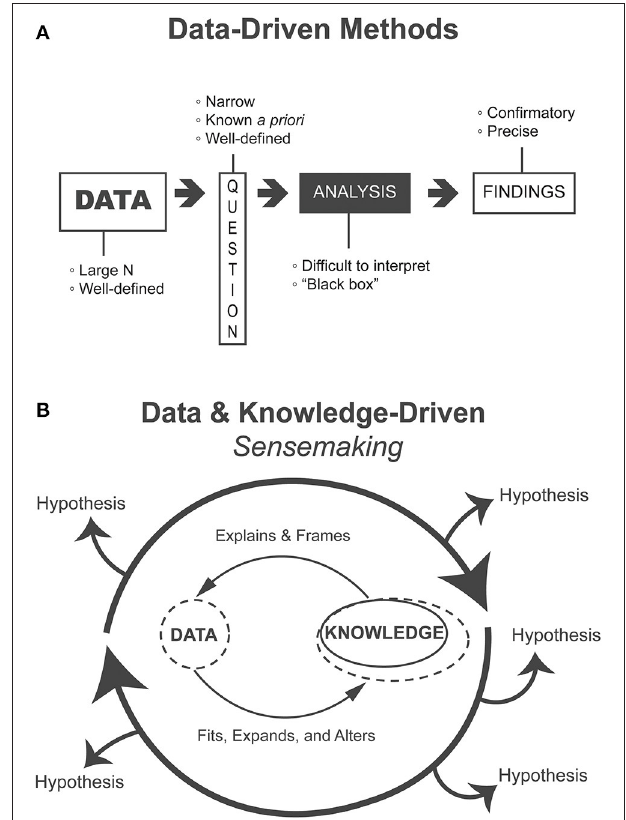
FIGURE 1 | (A) Heavily data-driven methods follow a linear flow from data to findings, require voluminous data to address narrow questions that are known ahead of the analysis, and produce confirmatory and precise findings but where analyses may be difficult to interpret “black boxes.” (B) Methods that support the data and knowledge-driven process of sensemaking iteratively generate, evaluate, and refine alternative hypotheses. Such methods are appropriate for exploratory and formative